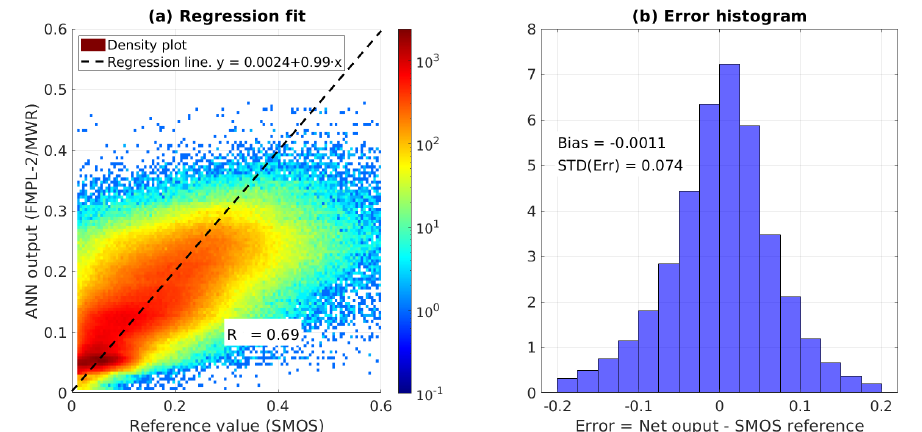
Figure 7. ( a ) Scatter-density plot between the ANN output using FMPL-2 data and the SMOS reference value; and ( b ) the error histogram between the ANN output and the SMOS